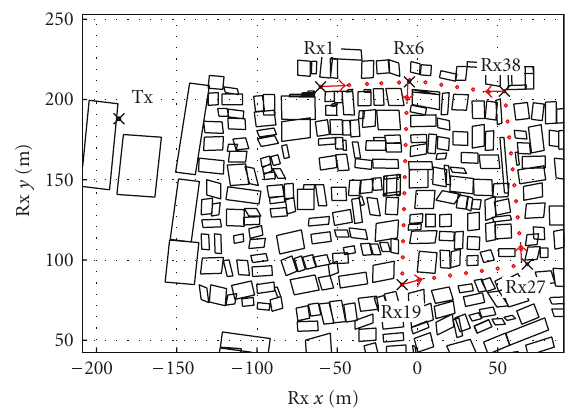
Figure 2: Map of macrocell measurement site.